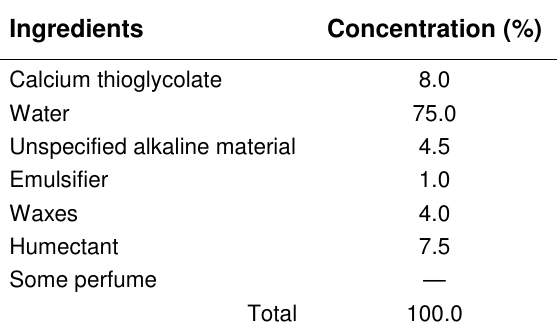
Ingredients of Nair®